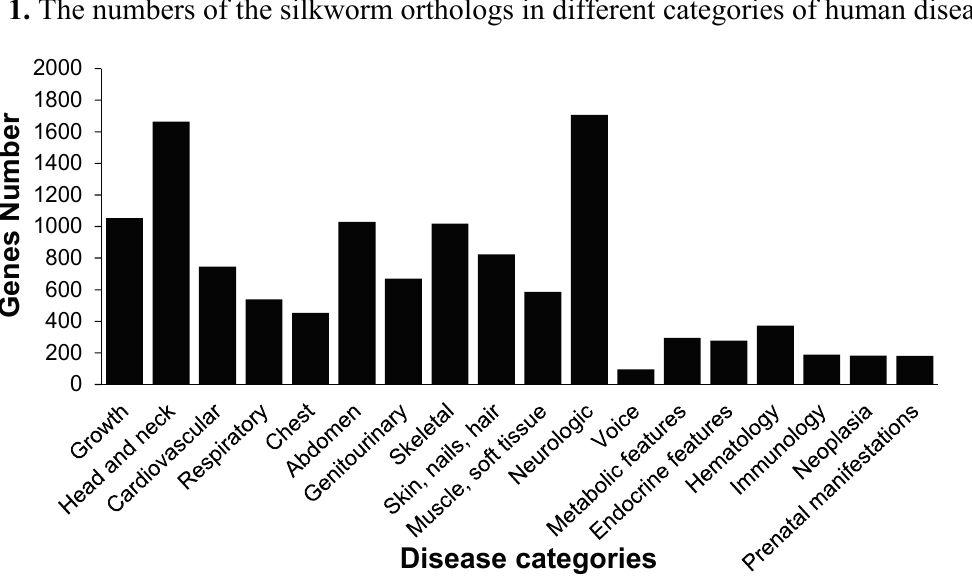
Figure 1. The numbers of the silkworm orthologs in different categories of human diseases.